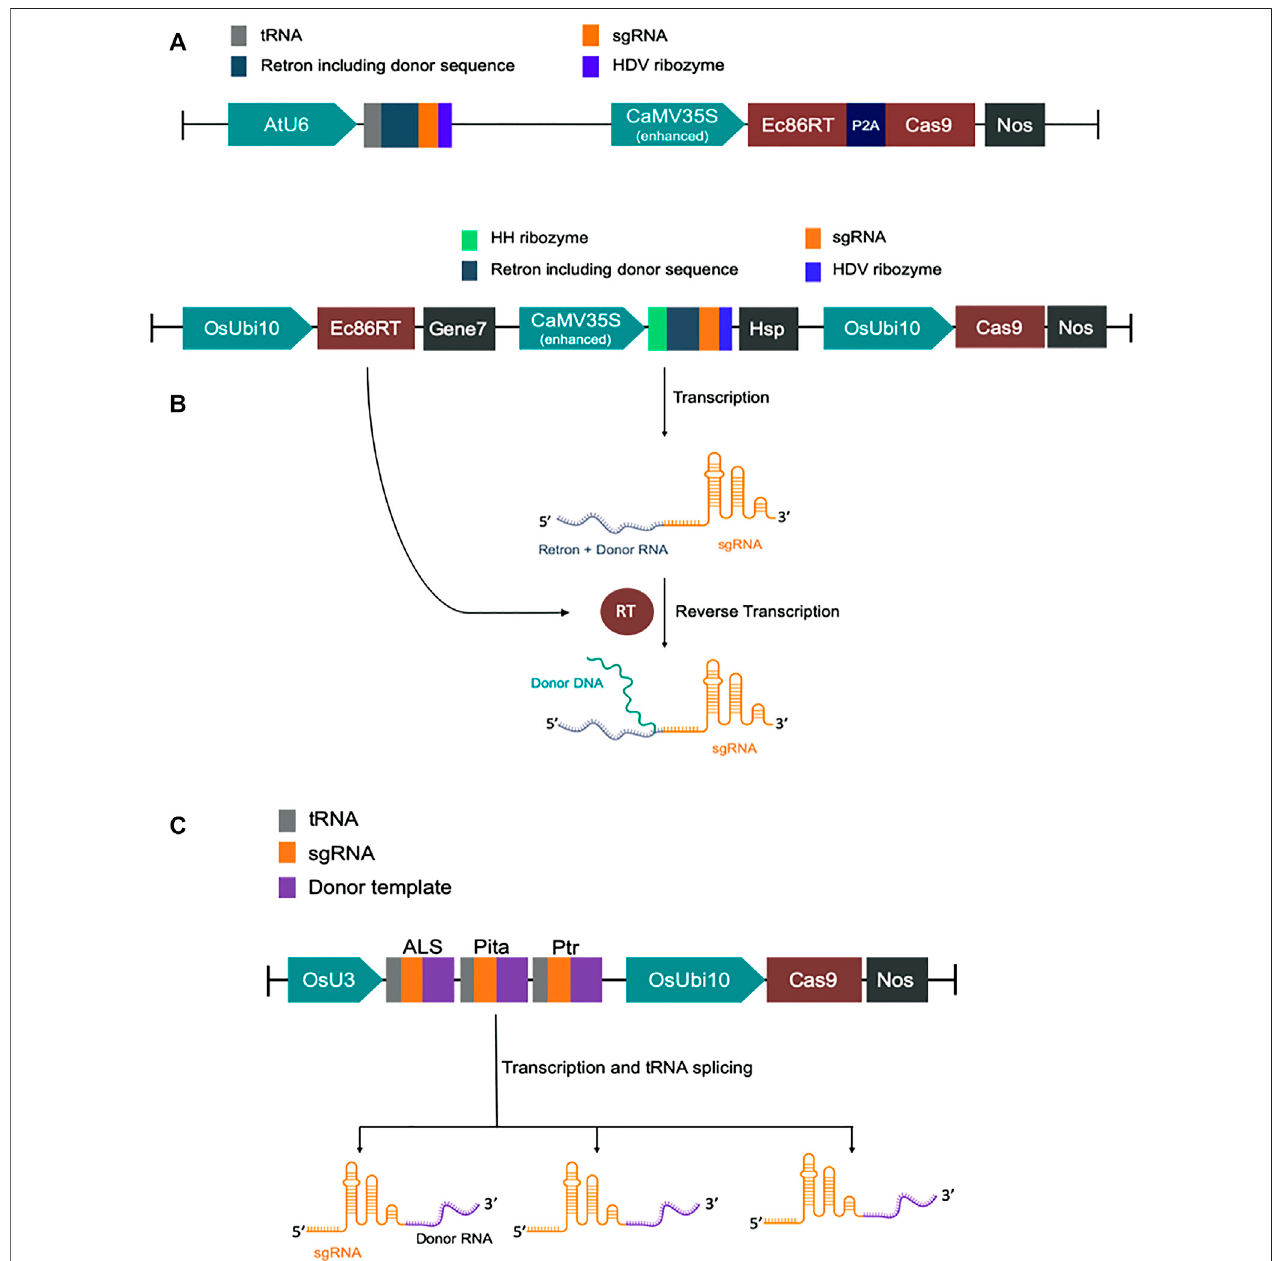
FIGURE 1 | Schematic diagram of DNA constructs. (A) Map of CRISPEY constructs used in Nicotiana benthamiana . (B) Map of pK-CRISPEY with donor used in rice. (C) Schematic diagram of pCgAPP construct.